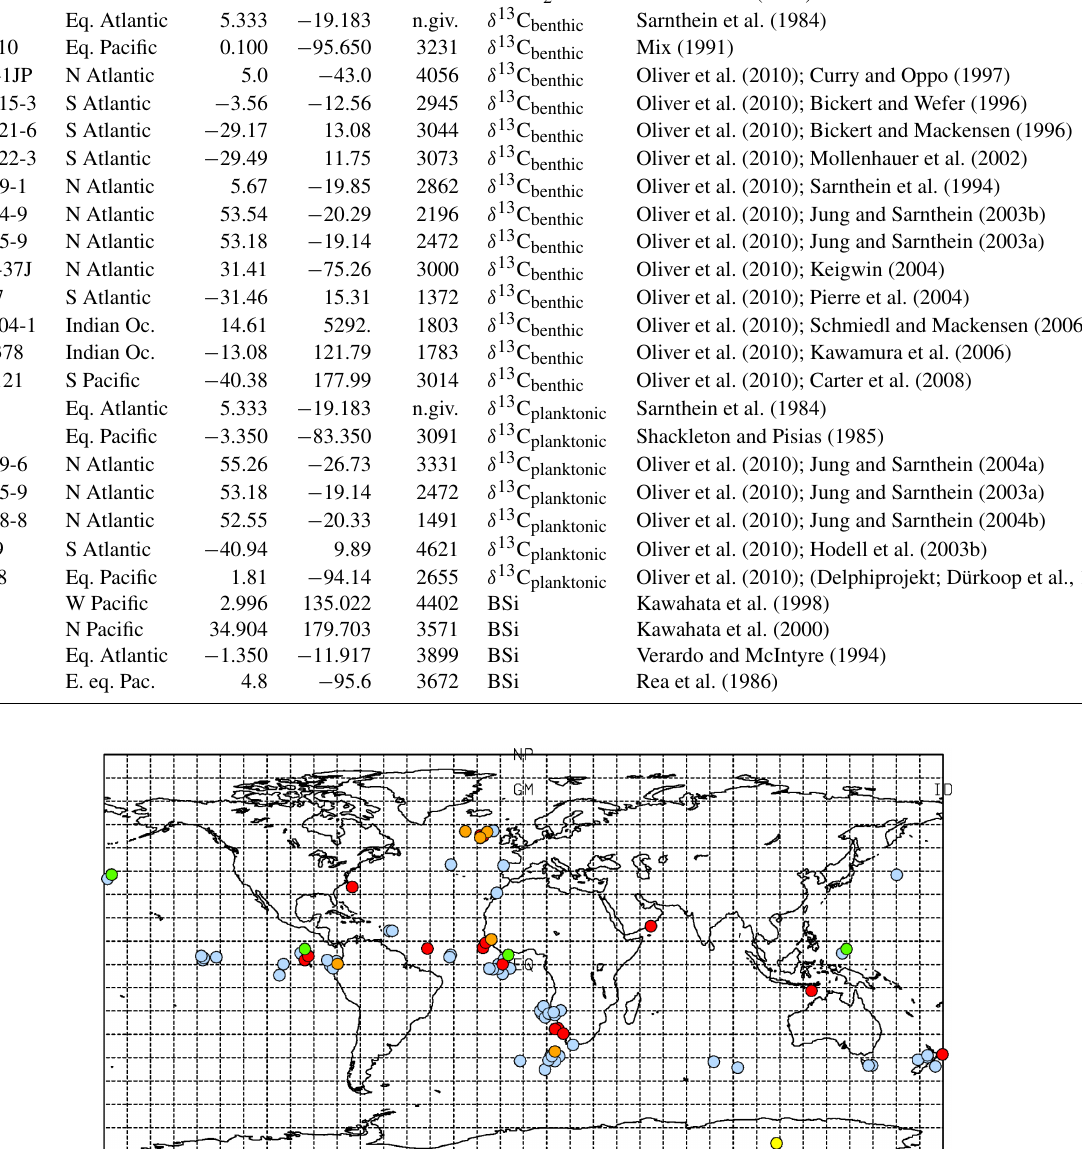
norm would be given by the inverse of the covariance